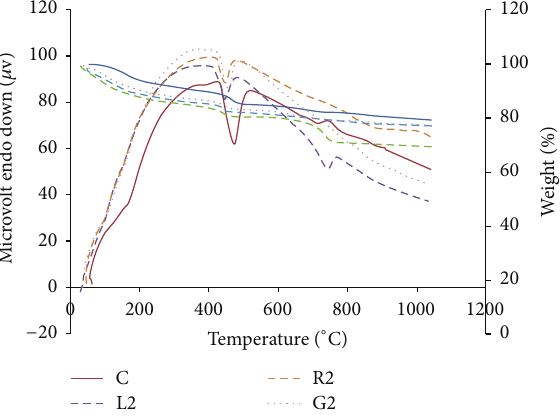
Figure 10: TG-DTA curves of C, L2, R2, and G2 at 90